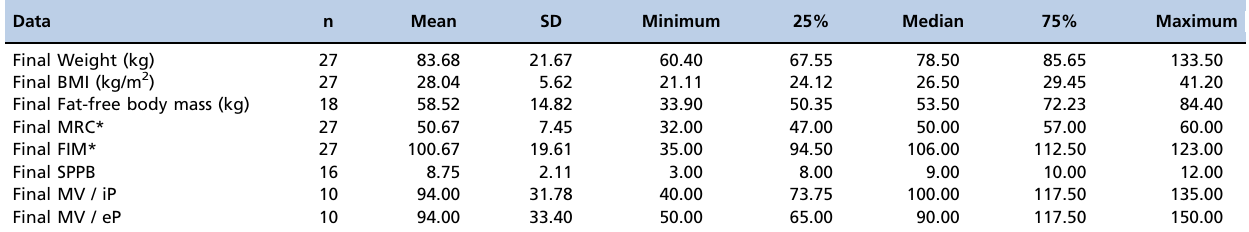
Table 3 - Continuous variables of the patients ’ characteristics at discharge from the inpatient rehabilitation treatment.